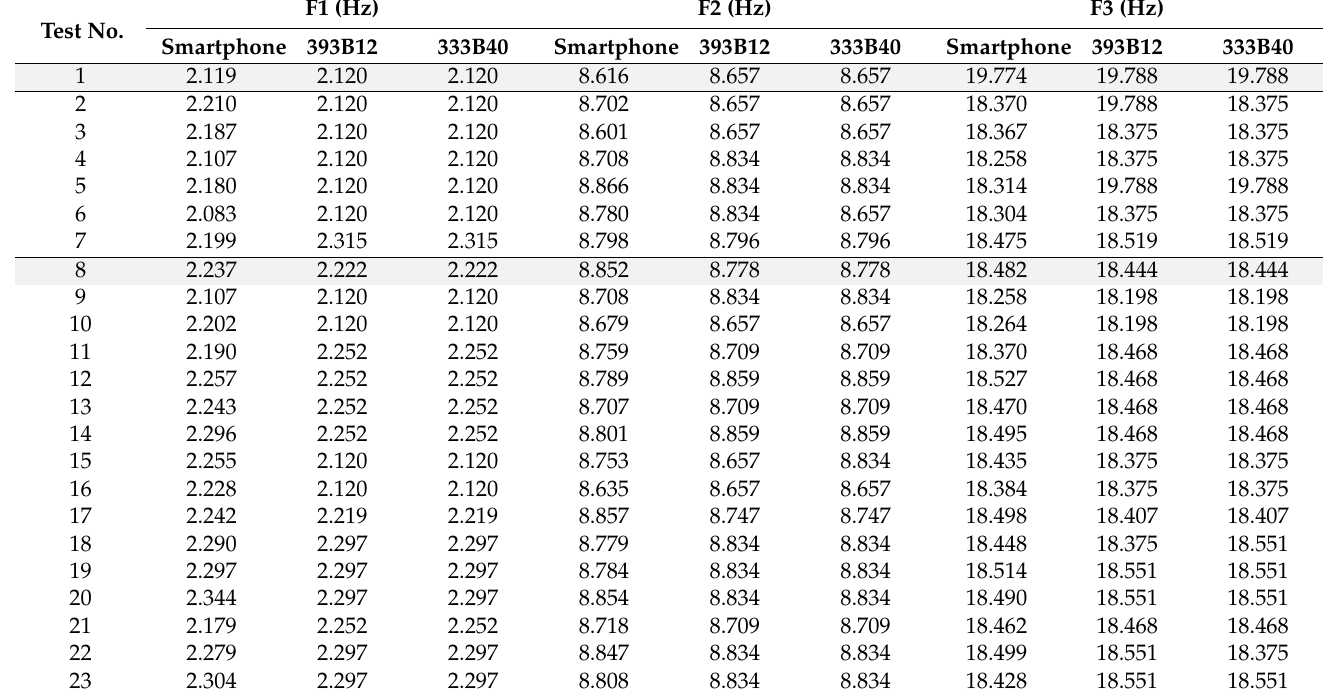
Table 1. Values, mean, standard deviation, and 95% confidence interval of the steel beam’s natural frequencies estimated with three sensing